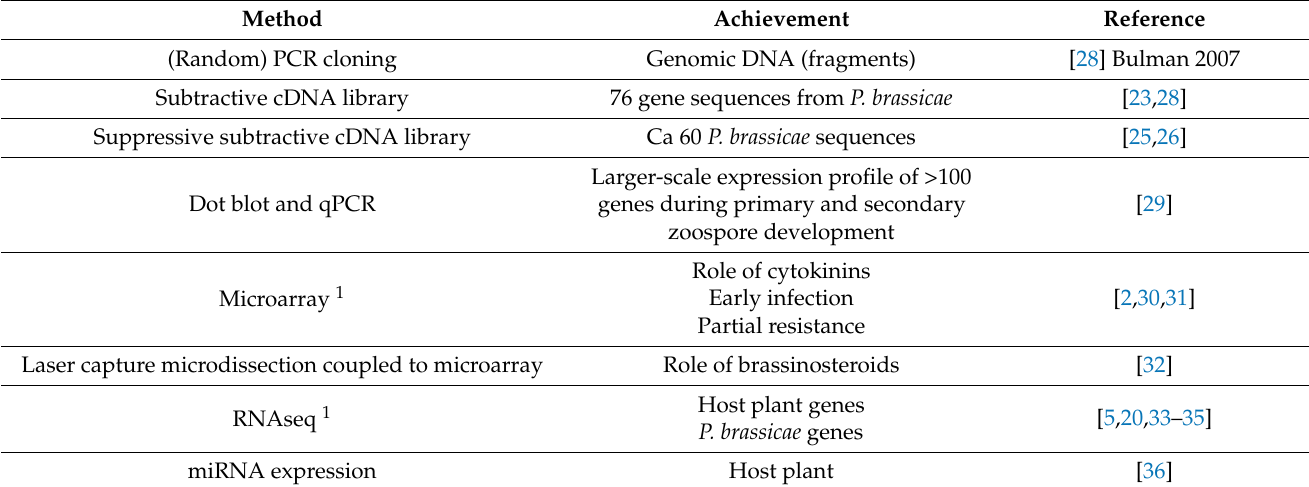
Table 1. The approaches historically and currently used to analyze transcripts on a more global level. The references are selected for a given technique and combination, but they are not